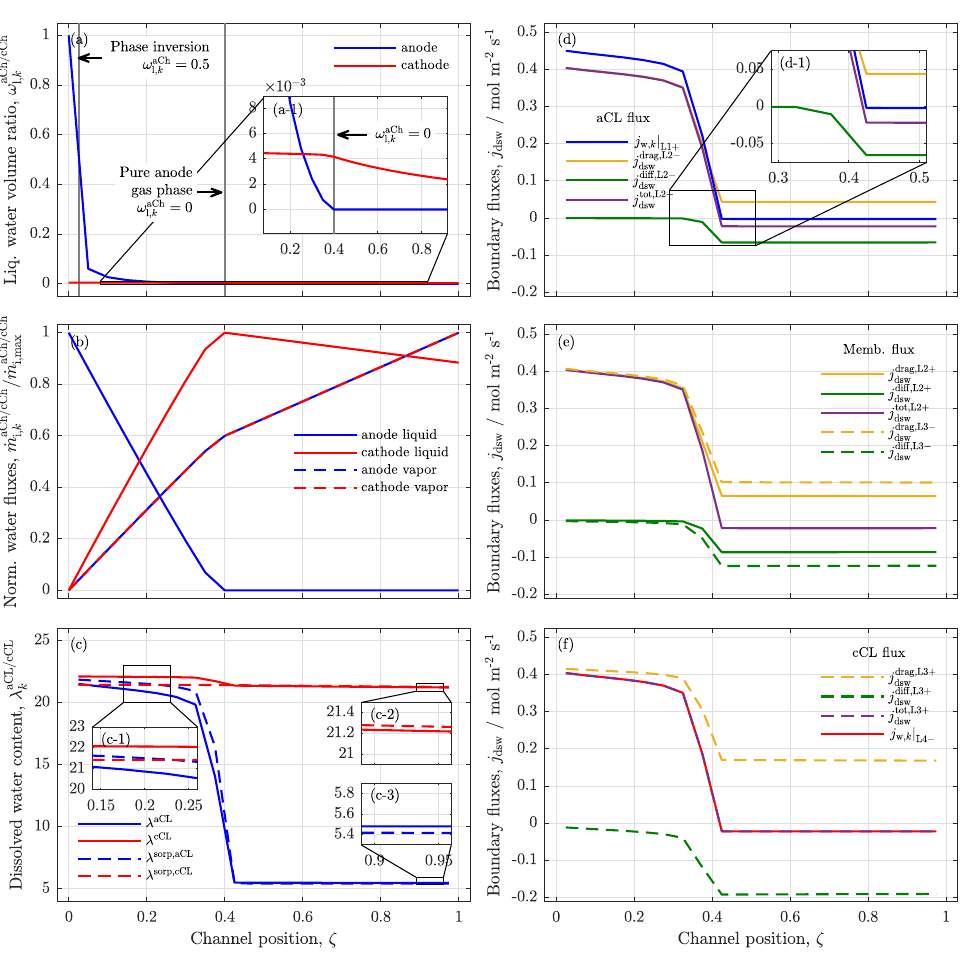
= 0.4gmin − 1 , T = Figure 6. Along the channel distributions at conditions E cell = 1.9V, ˙ m aCh H2O,in 60°C, ambient pressure of ( a ) liquid water volume ratios, ω aCh/cCh ; ( b ) normalized water flow rates l, k of anode and cathode liquid water and vapor, ˙ m aCh/cCh / ˙ m aCh/cCh with j : l, vap; ( c ) dissolved water j ,max j , k content in the catalyst layers, λ aCL/cCL and reference sorption water ratios (dashed lines, λ sorp ); k ( d ) water fluxes towards the aCL boundaries (liquid across L1, only dissolved water towards